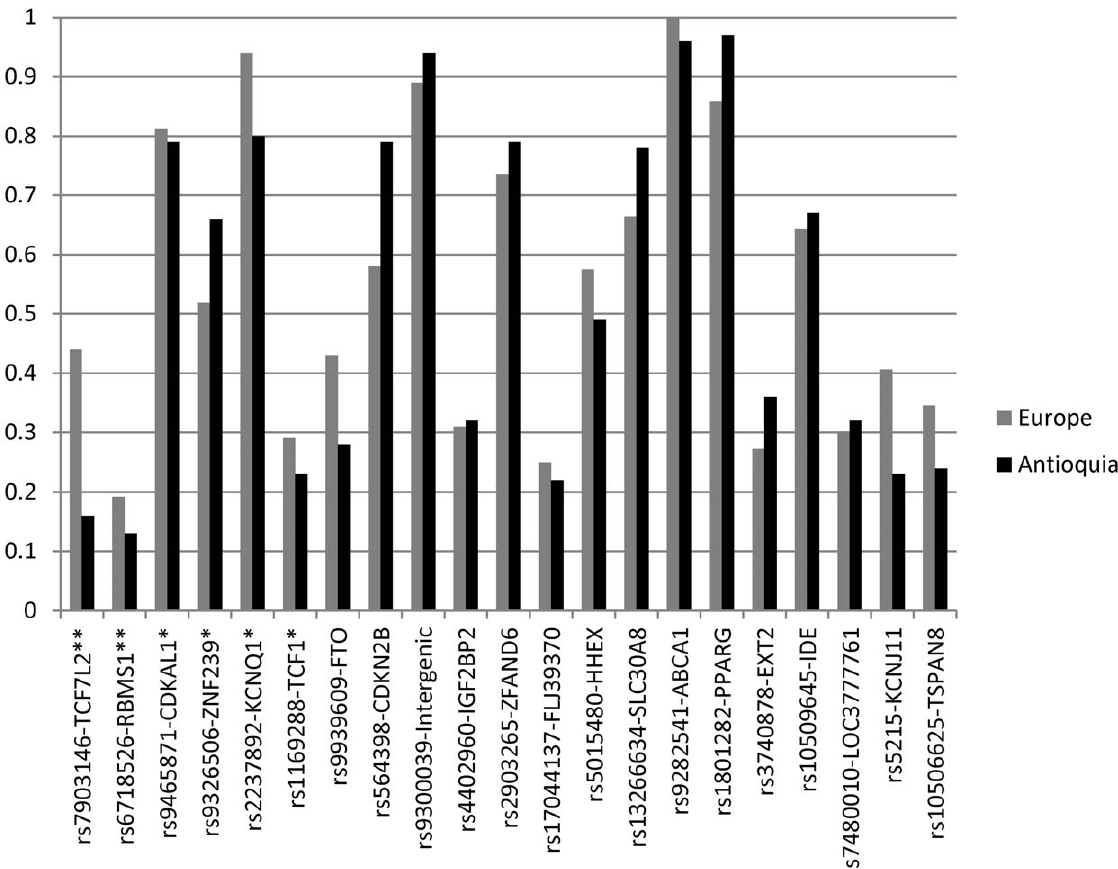
Figure 3. Frequency of the risk allele in Antioquian and in European controls for the marker (-gene region) typed. Markers have been ordered left to right based on the P-value obtained when testing for T2D association in the Antioquian case/control sample (Table 1). Asterisks indicate significance (** , 0.01; * , 0.05).